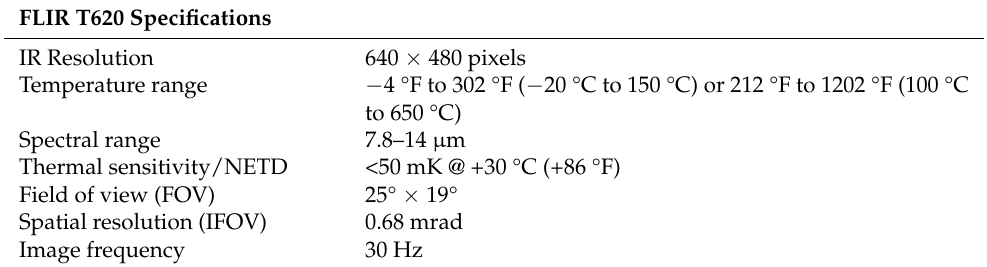
Table 1. Infrared camera specifications.